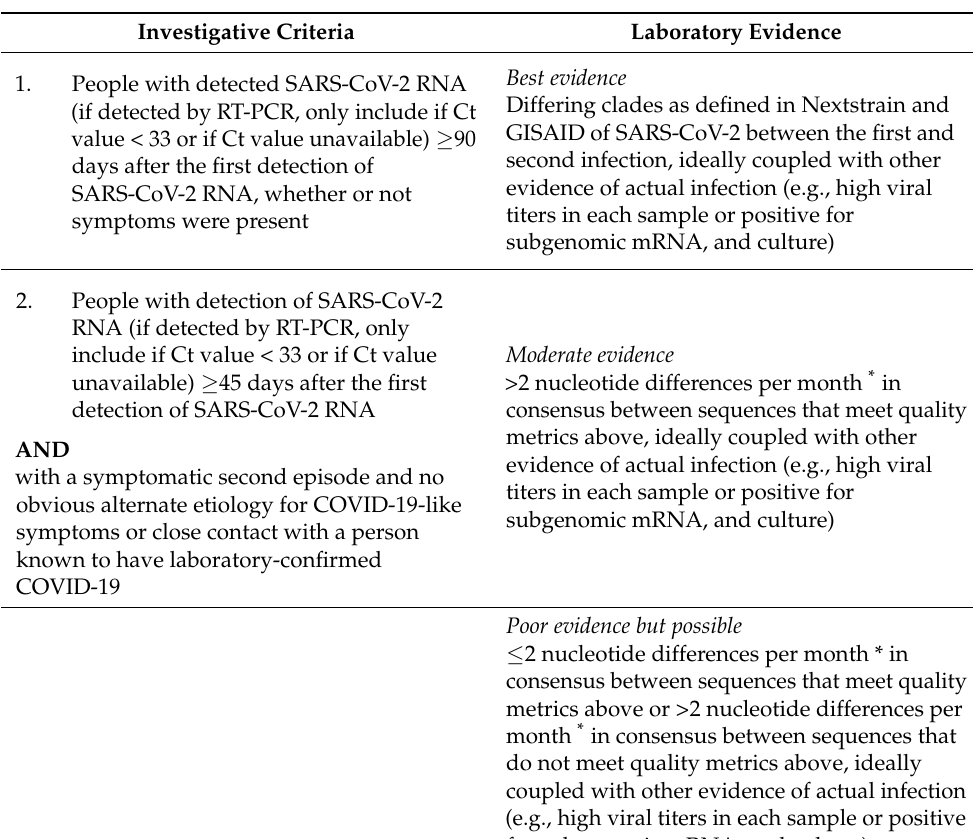
Table 1. Protocol of Center for Disease Control and Prevention for investigating suspected SARS- CoV-2